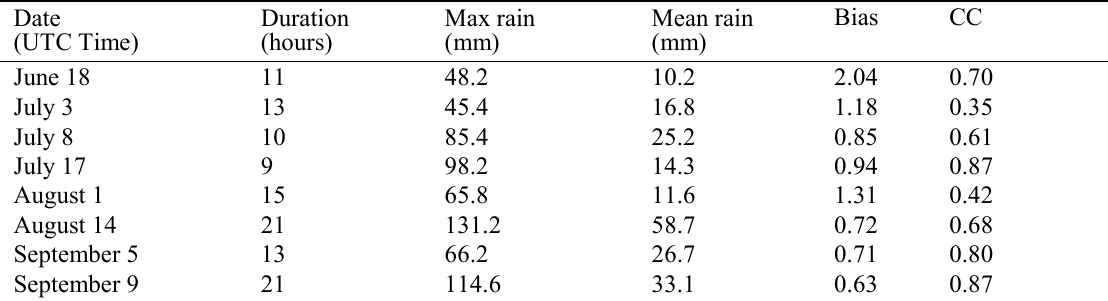
Table 1 Statistics for 8 typical storm events during 2010 summer in